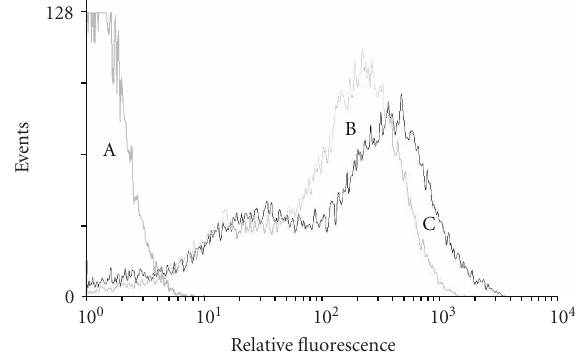
Figure 3: Flow cytometric analysis of GFP expression after induction of di ff erentiation. Nontransduced cNPCs and lenti- GDNF-GFP vector transduced cNPCs cultured under proliferation conditions (UM) were compared to transduced cNPCs cultured for 10 days in Ultraculture-based medium without EGF or bFGF and containing 10% FBS in order to induce di ff erentiation (UM- FBS). Curve A: nontransduced cNPCs as negative controls; curve B: lenti-GDNF-GFP transduced cNPCs and curve C: lenti-GDNF-GFP transduced cNPCs in UM-FBS. Induction of di ff erentiation did not attenuate expression of the GFP reporter